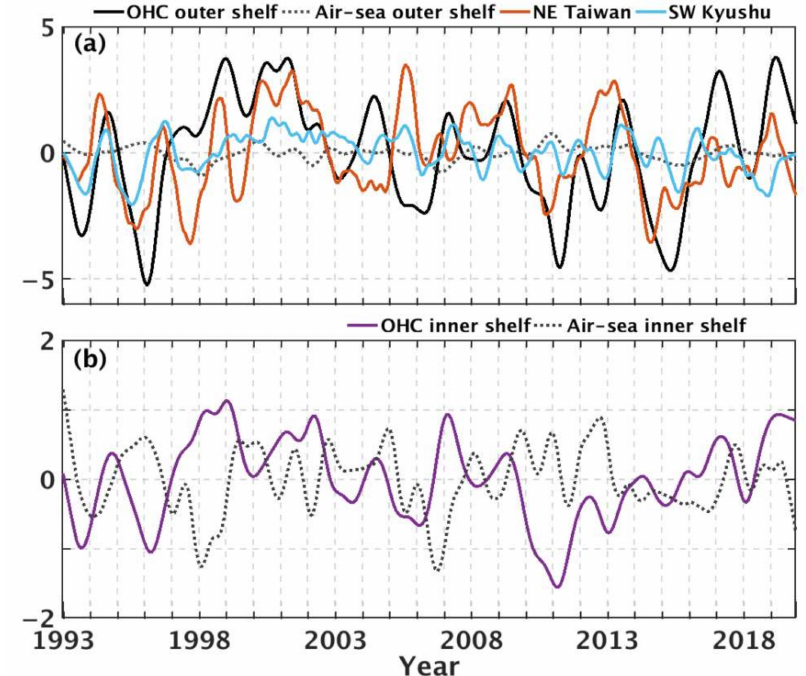
Figure 7. ( a ) Interannual OHC variations ( × 10 19 J, black solid line) and air-sea heat flux ( × 10 13 W, gray dash line) integrated over the outer shelf of the BYECS, heat transport ( × 10 14 W) across the SBS northeast of Taiwan (orange solid line) and that located southwest of Kyushu (blue solid line). ( b ) Interannual OHC variations ( × 10 20 J, purple solid line) and air-sea heat flux ( × 10 13 W, gray dash line) integrated over the inner shelf of the